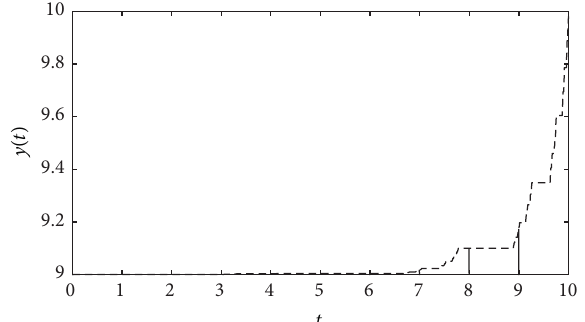
Figure 1: The chart of the signal 𝑦(𝑡) defined on Cantor sets.